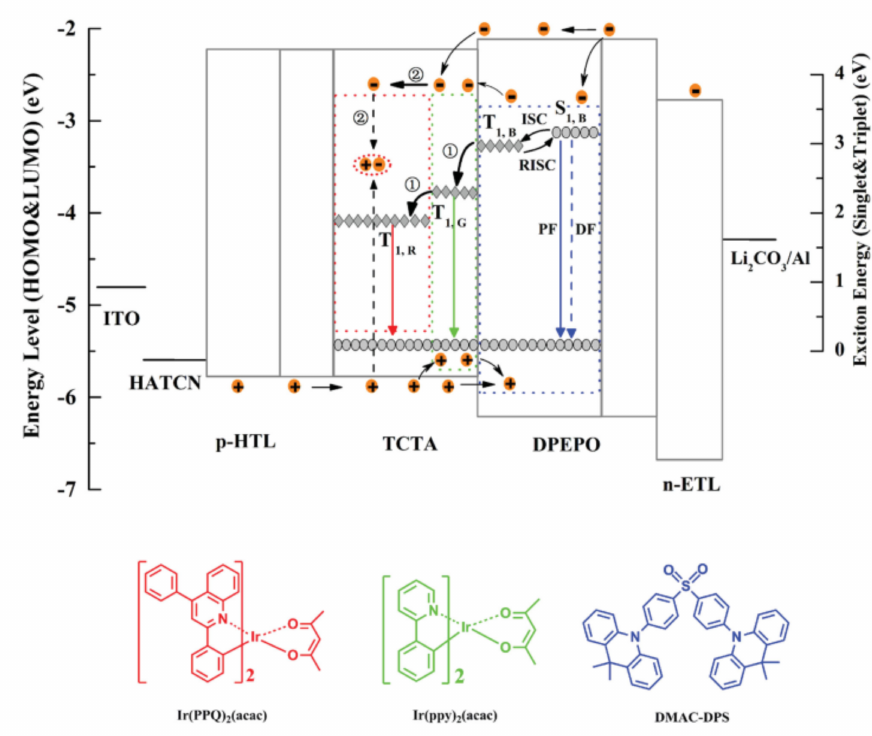
Figure 10. Proposed energy level diagram of the WOLED and chemical structures of emitters. R, G and B represent Ir(PPQ) 2 (acac), Ir(ppy) 2 (acac) and DMAC-DPS, respectively. Solid and dashed lines refer to HOMO and LUMO energy levels; circles and diamonds correspond to the exciton energies (S 0 , S 1 and T 1 ), respectively. 1 (cid:13) presents the energy transfer process and 2 (cid:13) is the carrier trapping process. PF is the prompt fluorescence, DF is the delayed fluorescence. Reproduced with permission from [154], John Wiley and Sons,